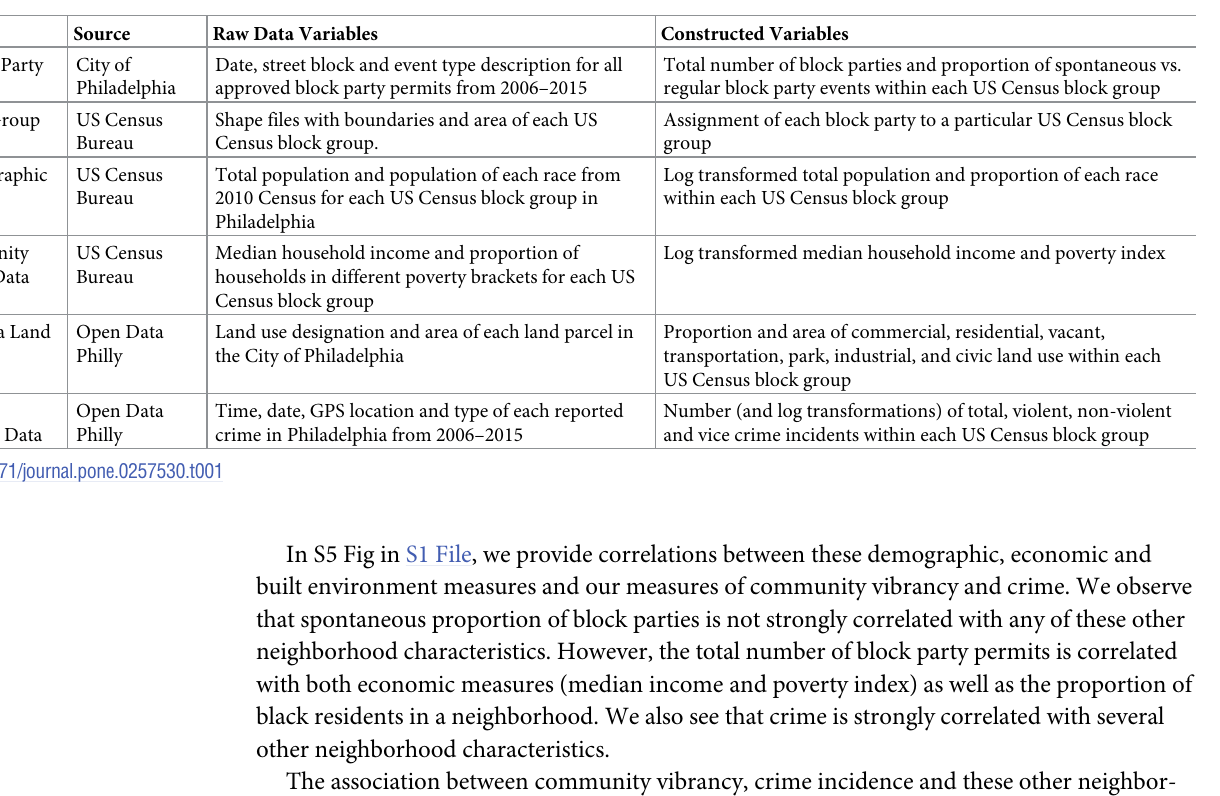
Table 1. Additional details about each data source used in our analysis. For each data type, we list the raw data variables used and any measures constructed from those data.